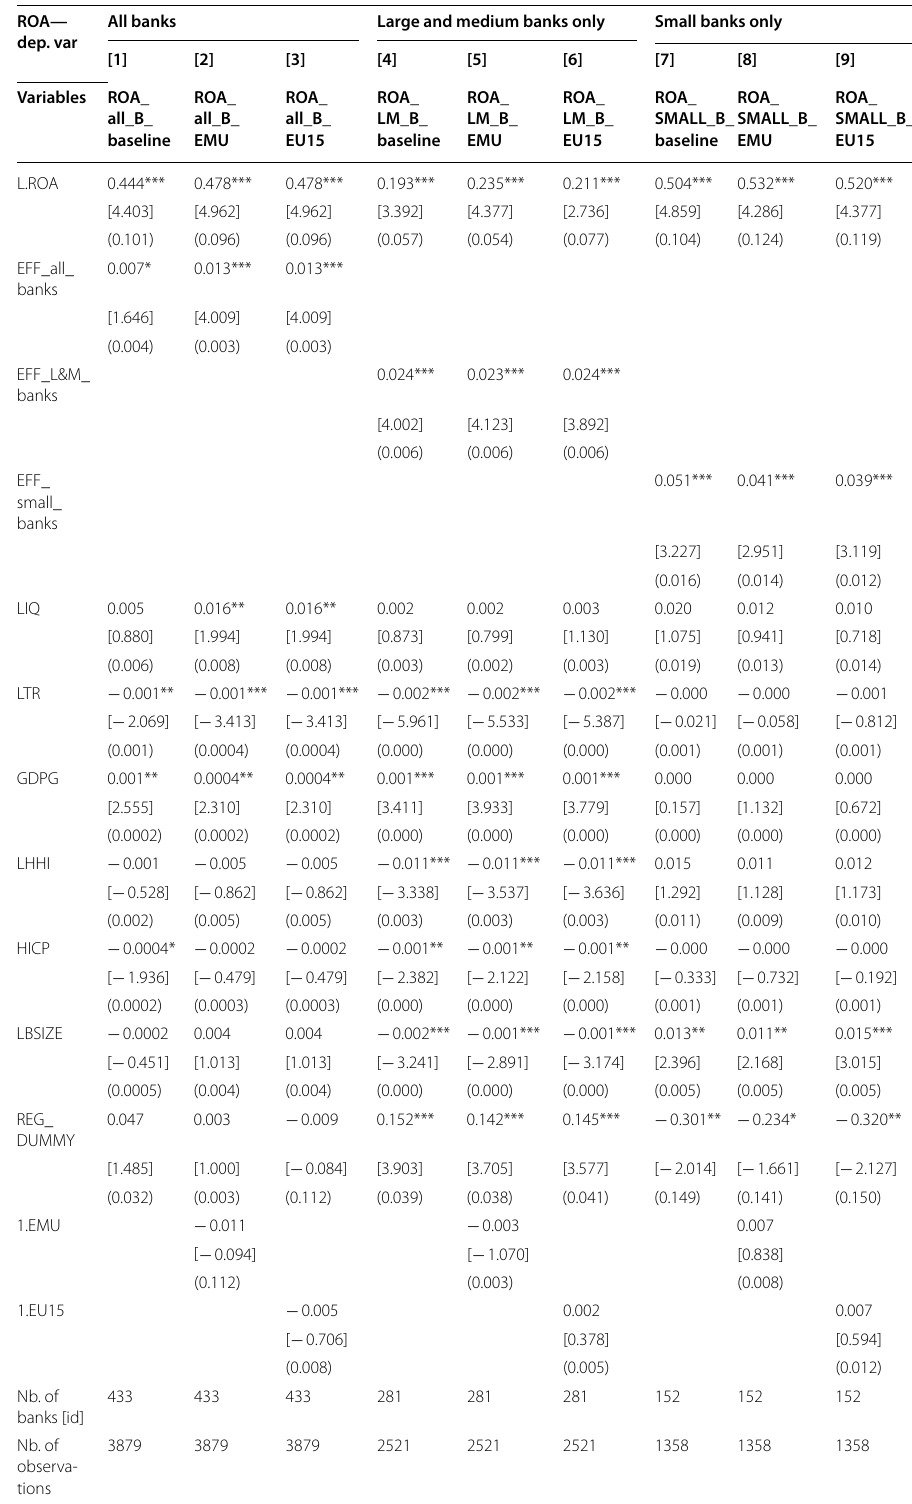
Table 7 Bank profitability determinants (for all banks jointly and separately for categories of banks with respect to their size) ROA— dep.